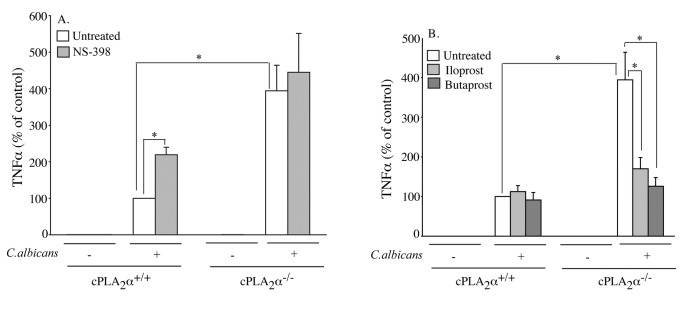
Role of prostaglandins in regulating C.
albicans-stimulated TNFα
production.cPLA2α+/+ and cPLA2α-/- RPM
were incubated with (A) NS-398 (10 µM), or (B) iloprost (1 µM) or
butaprost (10 µM) for 30 min followed by incubation with
C.
albicans for 6 h. Levels of TNFα in the
culture medium were determined by ELISA. The data are the average of 3
experiments ±S.E. (*p<0.05).